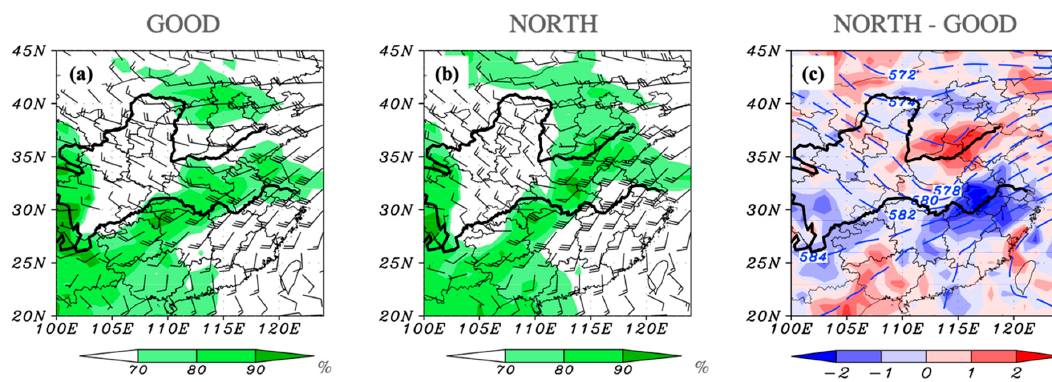
Figure 12. 700-hPa relative humidity (%, colored) and wind vectors (knots, black barbs, typical meteorological convention) for ( a ) the GOOD subset and ( b ) the NORTH subset, and ( c ) the normalized difference of relative humidity (colored) between the two subsets along with the NORTH subset 500 hPa geopotential heights (dam, blue dashed). Panels are valid at 0000 UTC 1 July, derived from the ECMWF EPS initialized at 1200 UTC 28 June 2016. Thin black contours denote political boundaries and thick black lines denote the Huanghe and Yangtze Rivers to the north and south,